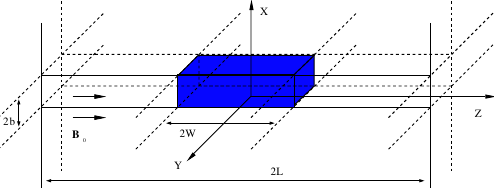
Fig. 50 Sketch of the thread equilibrium model used by Joarder et al. (1997), Díaz et al. (2001, 2003). The blue zone of length 2 W represents the cold part of the flux tube, i.e., the prominence thread. The length of the magnetic structure is 2 L and the thread thickness (equivalent to its diameter) is 2 b . The magnetic field is uniform and parallel to the z -axis, and the whole configuration is invariant in the y -direction. Image reproduced with permission from Díaz et al. (2001), copyright by